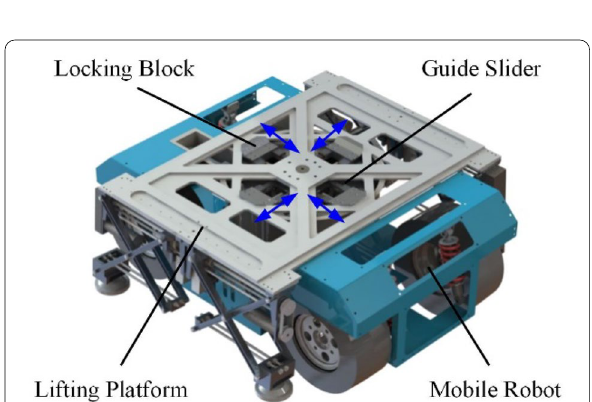
Figure 3 Schematic diagram of the docking state